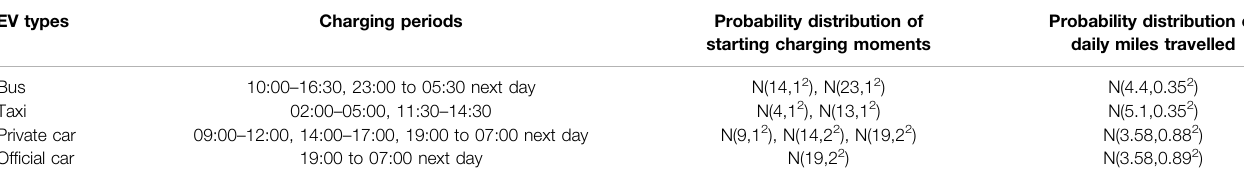
TABLE 3 | Driving characteristic parameters of the